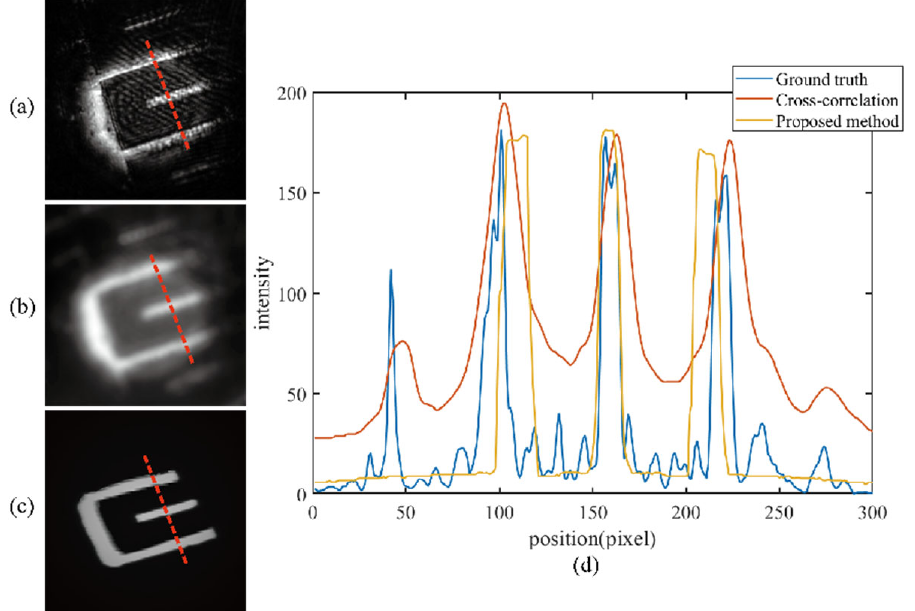
Figure 11. Experimental results of a MEMS element. ( a ) Ground truth; ( b ) Result of the cross ‐ correlation algorithm (SSIM: 0.2651); ( c ) Result of the proposed strategy (SSIM: 0.5793); ( d ) Intensity values of the red dashed lines in ( a – c ).